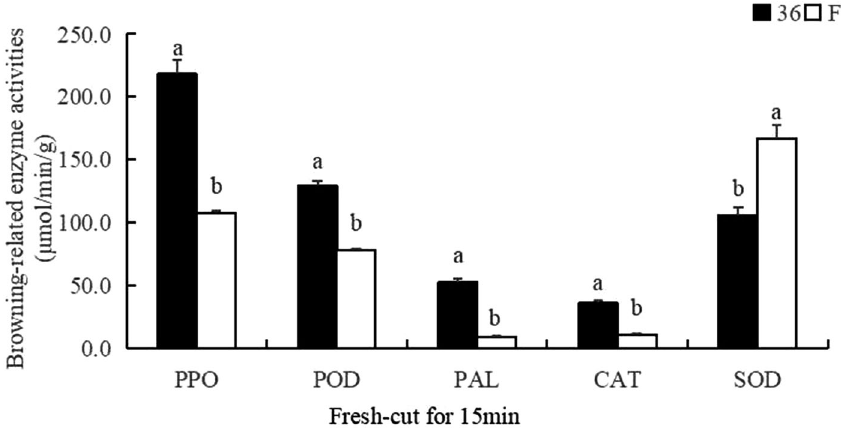
Figure 13. The enzyme activities of PAL, SOD, CAT, PPO, and POD in ‘36’ and ‘F’ after fresh-cut 15